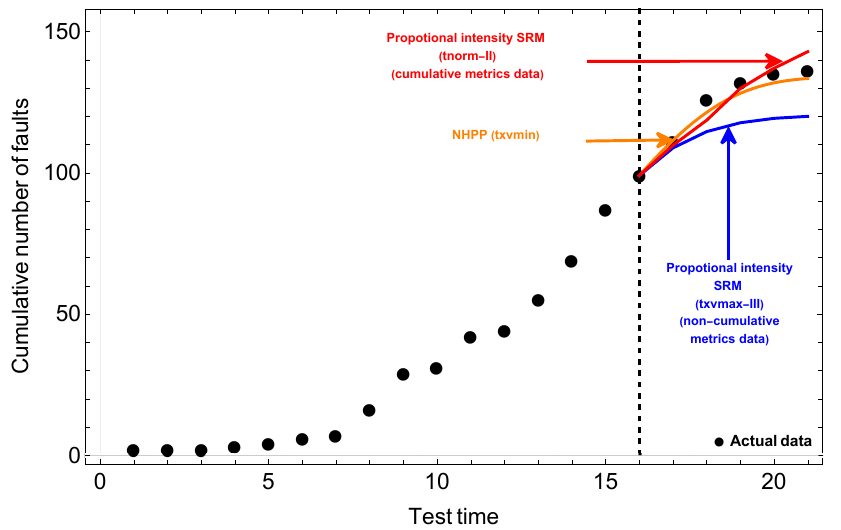
Figure 3. Behavior of the predicted cumulative number of software faults with PI-SRMs and common NHPP-based SRM in GDS1 (50% observation point).